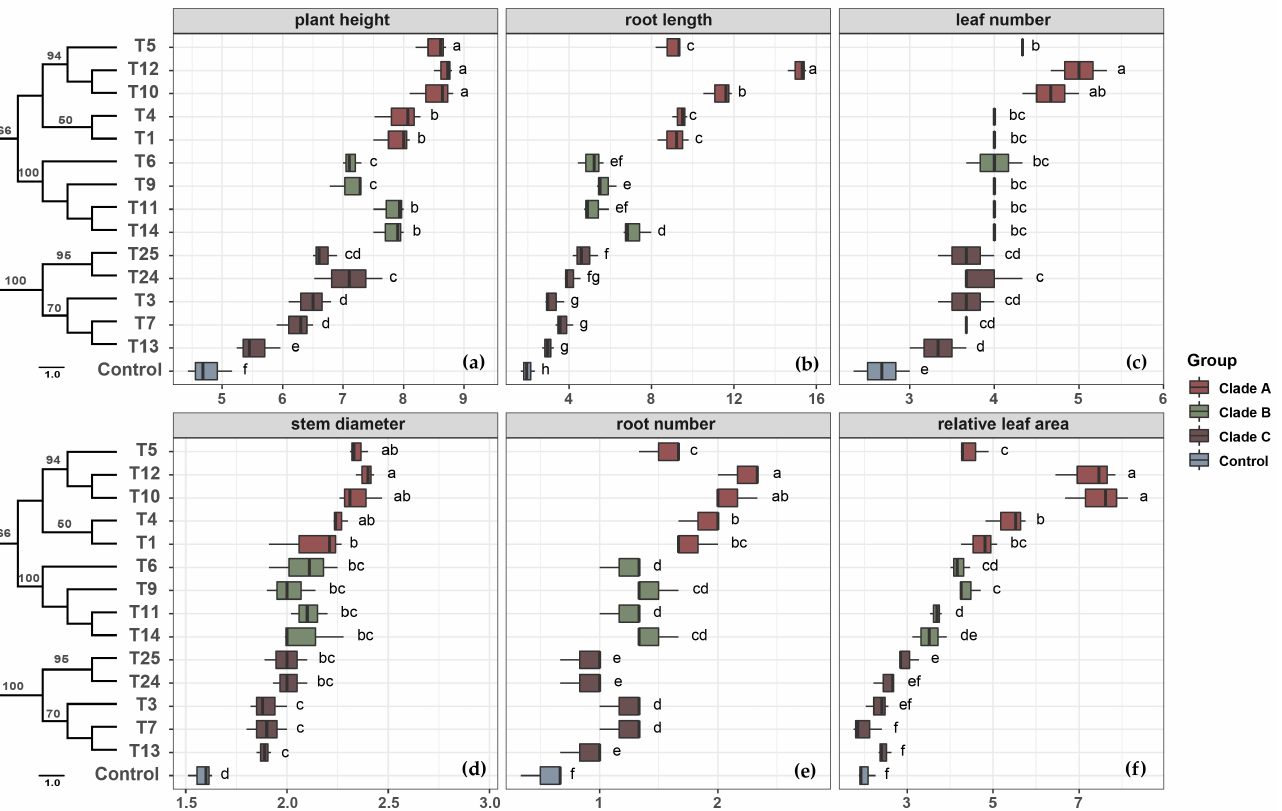
Figure 7. The growth of different fungi and D. crepidatum protocorm on day 90 of symbiosis. ( a ) The average plant height of symbionts; ( b ) The average root length of symbionts; ( c ) The average leaf number of symbionts; ( d ) The average stem diameter of symbionts; ( e ) The average root number of symbionts; ( f ) The relative leaf area of symbionts. Strains with different lowercase letters are significantly different ( p < 0.05) based on the LSD